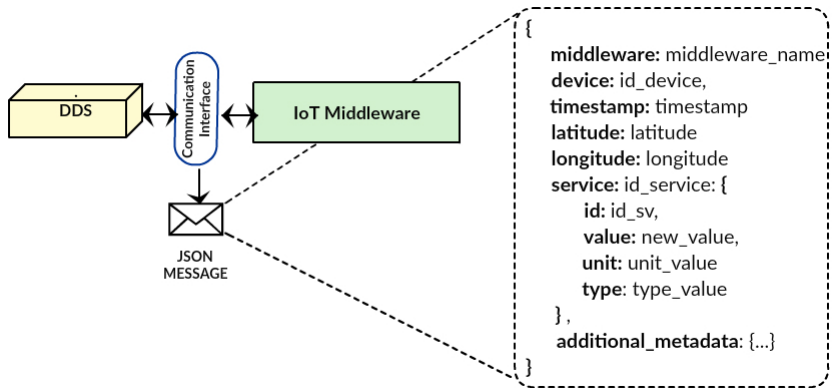
Figure 4. Communication interface between the DDS and the IoT middleware.